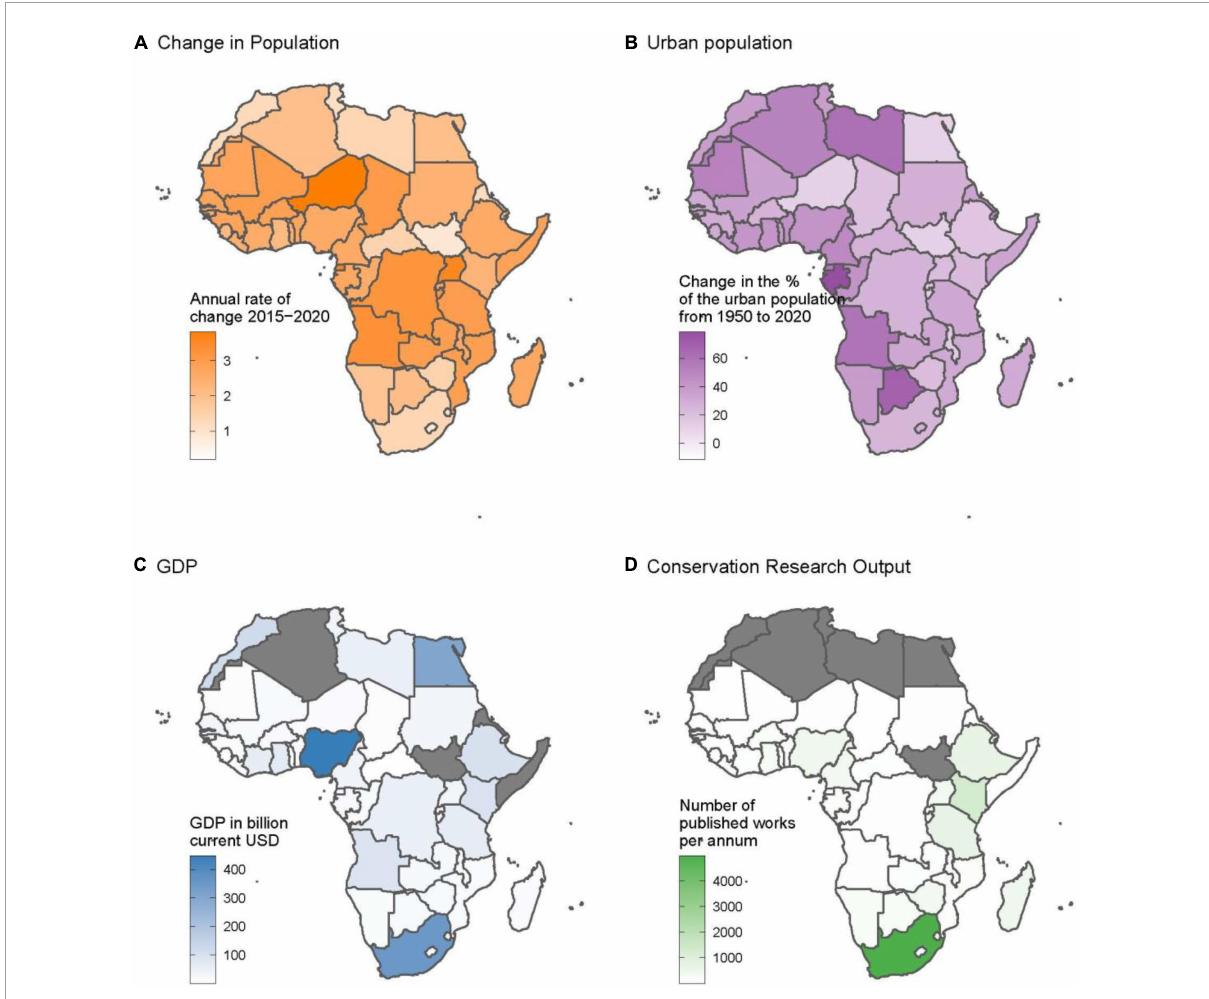
FIGURE2 Variation among African countries in factors that influence the conservation of biodiversity: (A) The percentage with which the population of African countries grows each year, (B) urbanization, (C) GDP, and (D) conservation research output [number of published works per annum based on the Scopus database—a relationship between research output and conservation success has been demonstrated (Hu et al., 2019)]. Data from population.un.org, data.worldbank.org, and Lan et al. (2014) and Makaya (2017). Data were not available for countries in